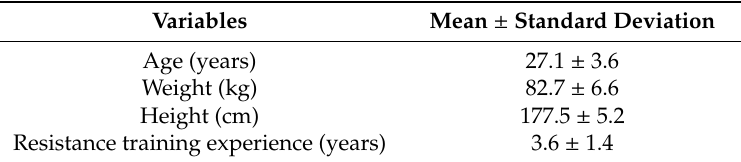
Table 1. Characteristics of the participants.